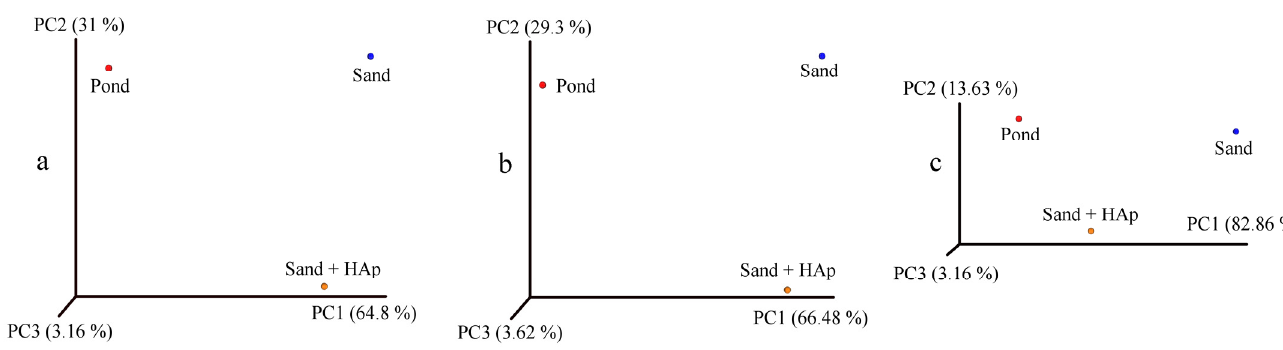
Figure 3. Krona plots focused on the most abundant of all phyla in the untreated ( a ) and treated ( b ) soil samples, namely Proteobacteria.